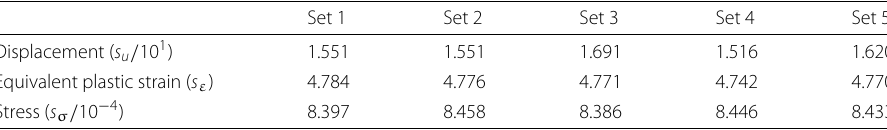
Table 4 Scaling constants for the different training sets Set 1 Set 2 Set 3 Set 4 Set